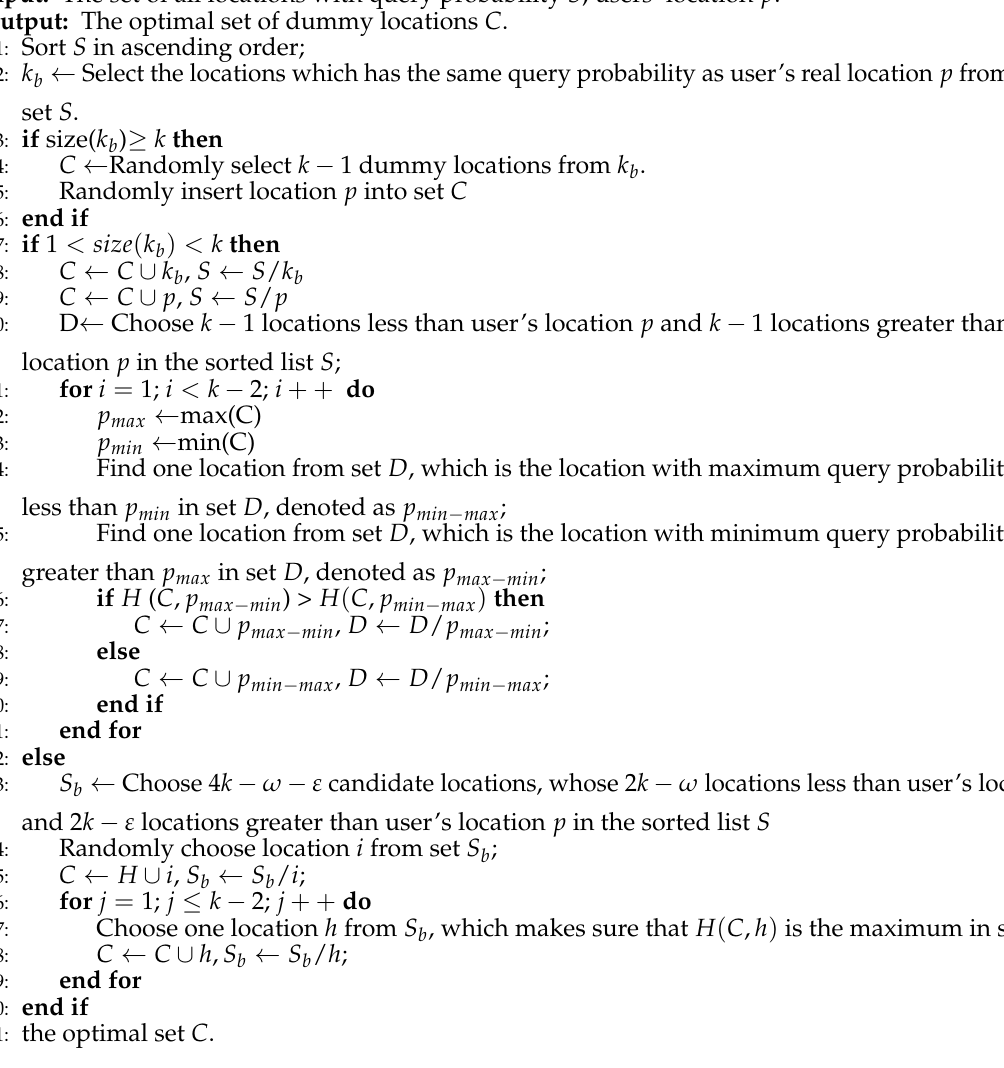
Algorithm 1 Enhanced-DLP